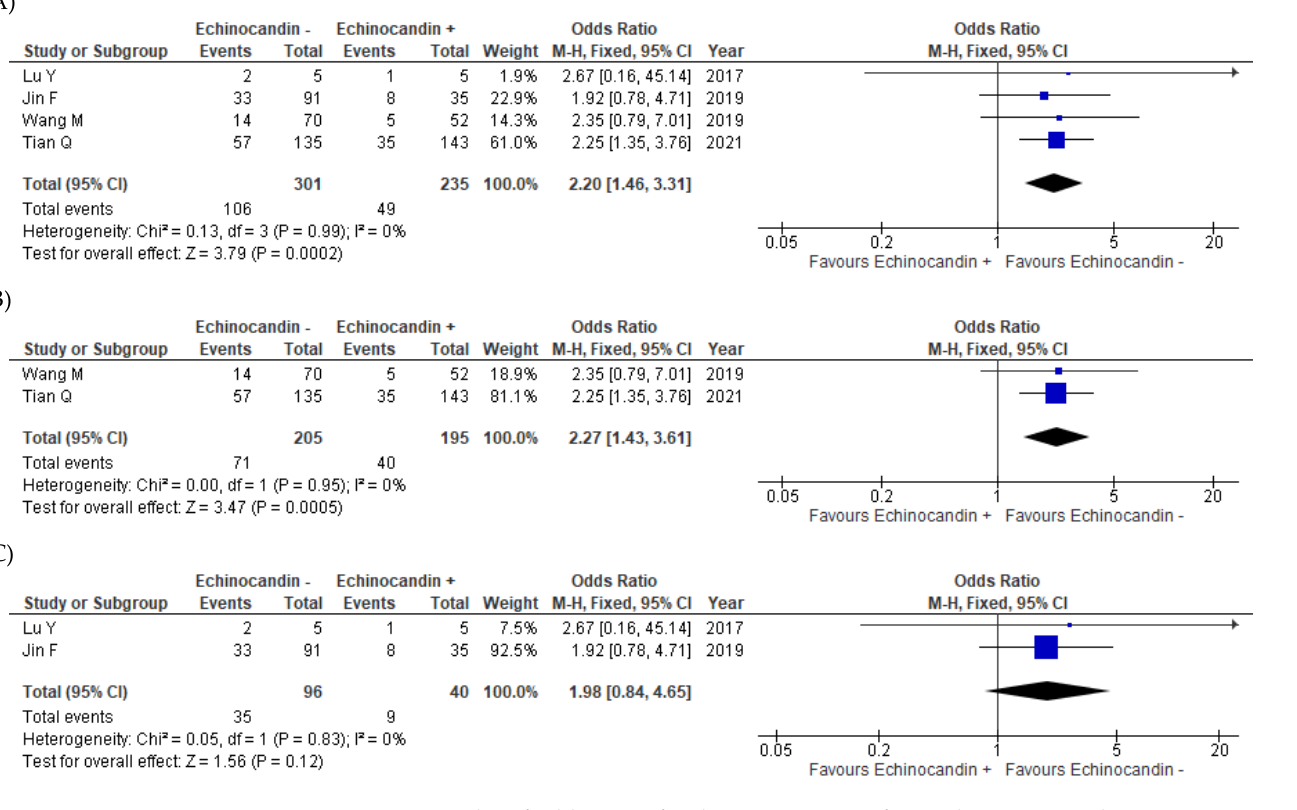
Figure 2. Forest plot of odds ratios for the comparisons of mortality outcomes between patients with